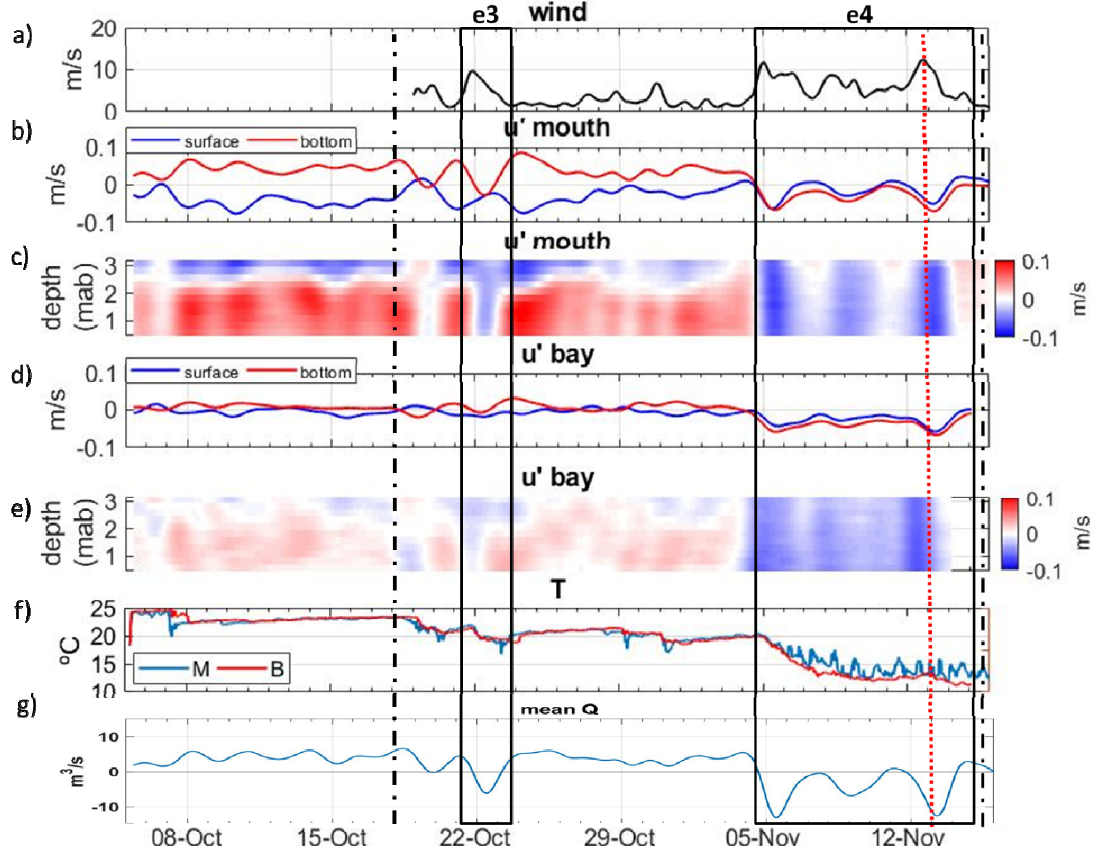
Figure 9. From top to bottom, wind speed ( a ), alongshore currents in the mouth ( b ), Hovmöller diagram in the mouth for the alongshore currents ( c ), alongshore currents in the bay ( d ) and Hovmöller diagram in the bay for the alongshore currents ( e ), and bottom temperature ( f ) in the mouth (blue) and the bay (red), mean flow (positive inflow) in the mouth ( g ). The black boxes show the NW events. The dotted lines mark the days of the vertical sections shown in Figure 10.